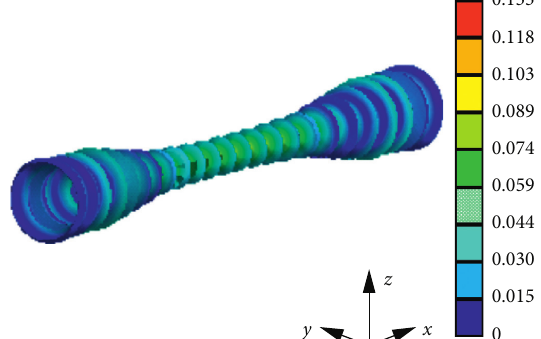
Figure 12: Expansion-contraction mode shape of the busbar shell at 2900Hz in ANSYS